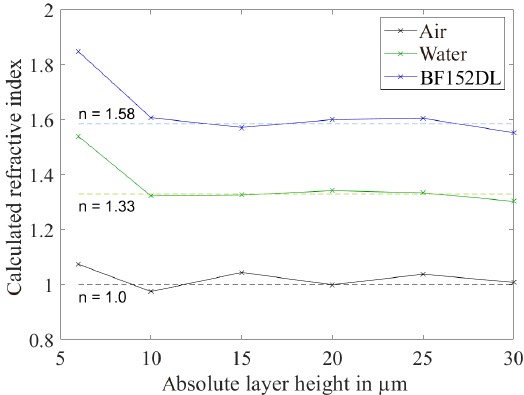
Figure 10. Dependence of the calculated refractive index on the measured layer thickness.